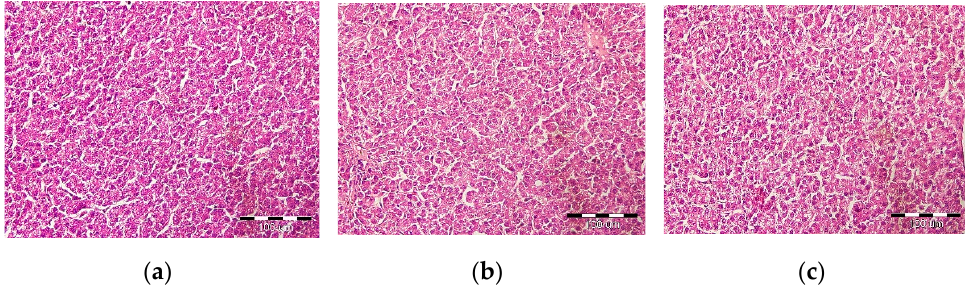
Figure 1. Histopathological examination of hens’ liver: ( a ) TM0—hens receiving control diet; ( b ) TM2—hens receiving a diet with 2% of mealworm meal; ( c ) TM5—hens receiving a diet with a proportion of 5% of mealworm meal.